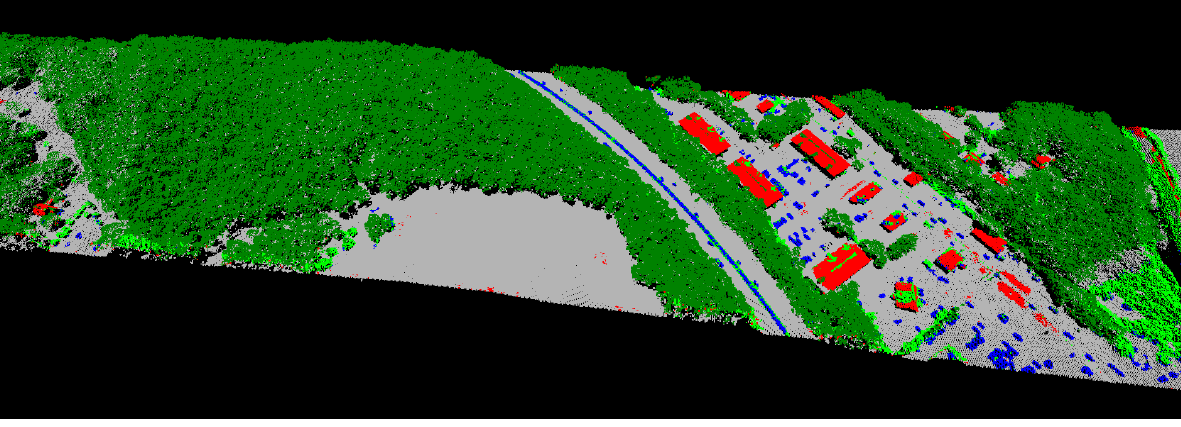
Figure 4. Classified point cloud for the GML Dataset A with five classes ( Ground : gray; Building : red; Car : blue; Tree : dark green; Low Vegetation : bright green).